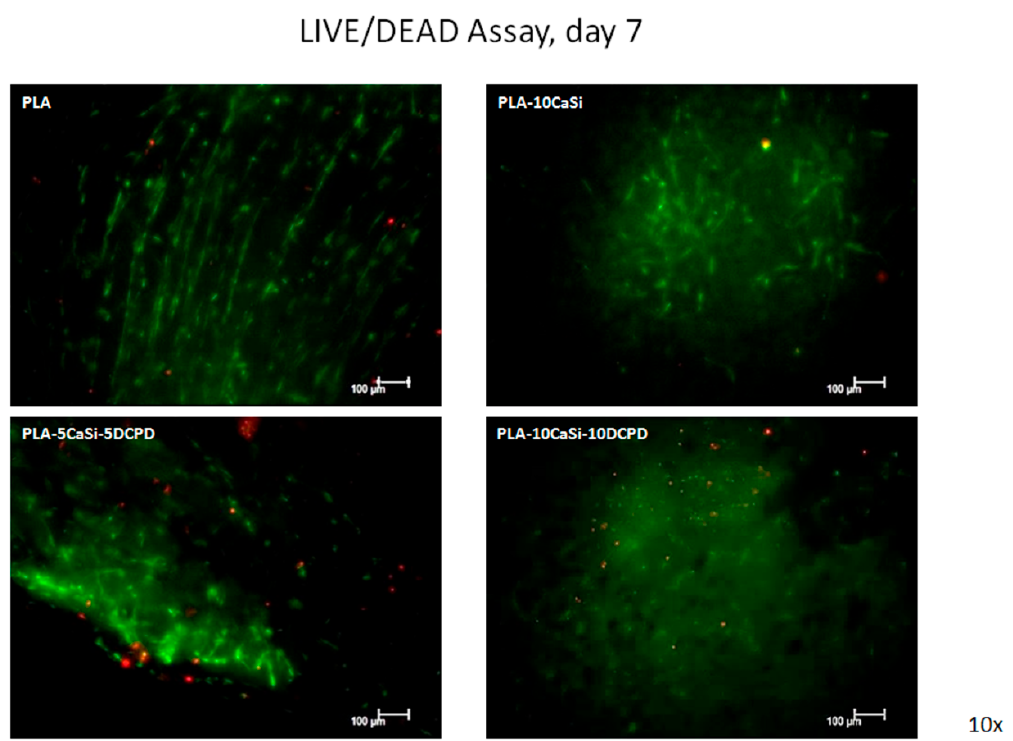
Figure 9. Live/dead assay. Live/dead staining, at day 7 of culture, in order to detect viable (green) and non-viable (red) hPCy-MSCs within the tested scaffolds (CLSM, 10× magnification).